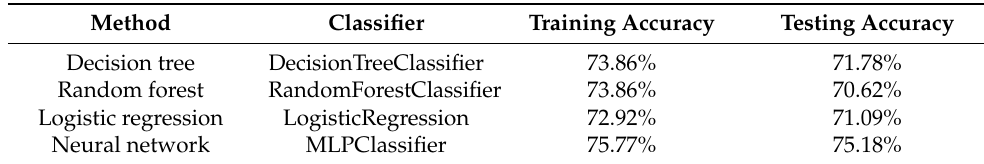
Table 2. ML training results in comparison among different methods.